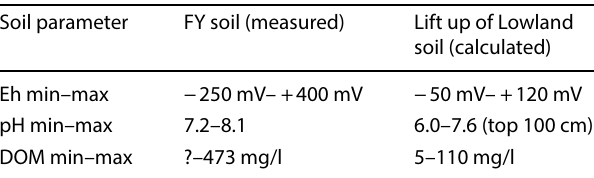
Table 4 General soil parameters, measurements [32] versus FIAM model results Soil parameter FY soil